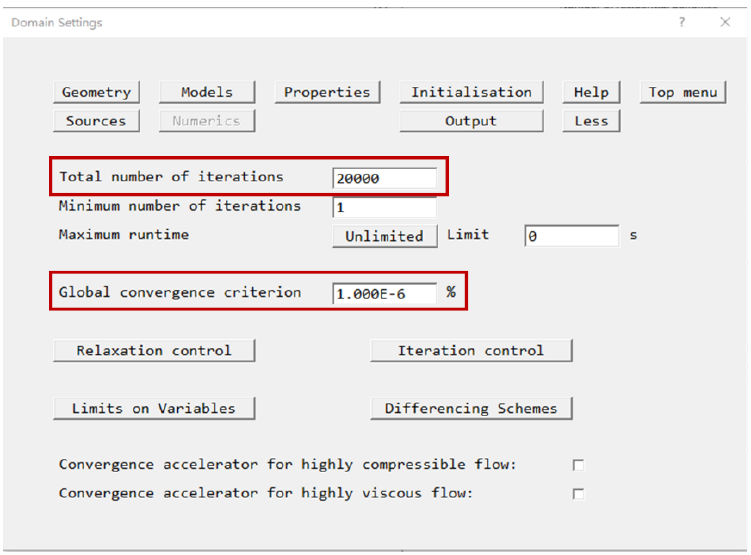
Figure A6. Iteration steps and residual settings.